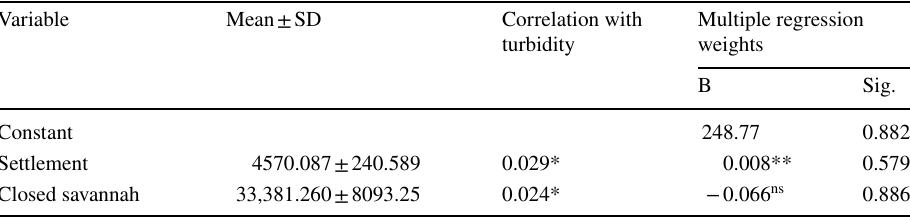
R 2 = 0.409, ns = Not significant, b = Unstandardized coefficients